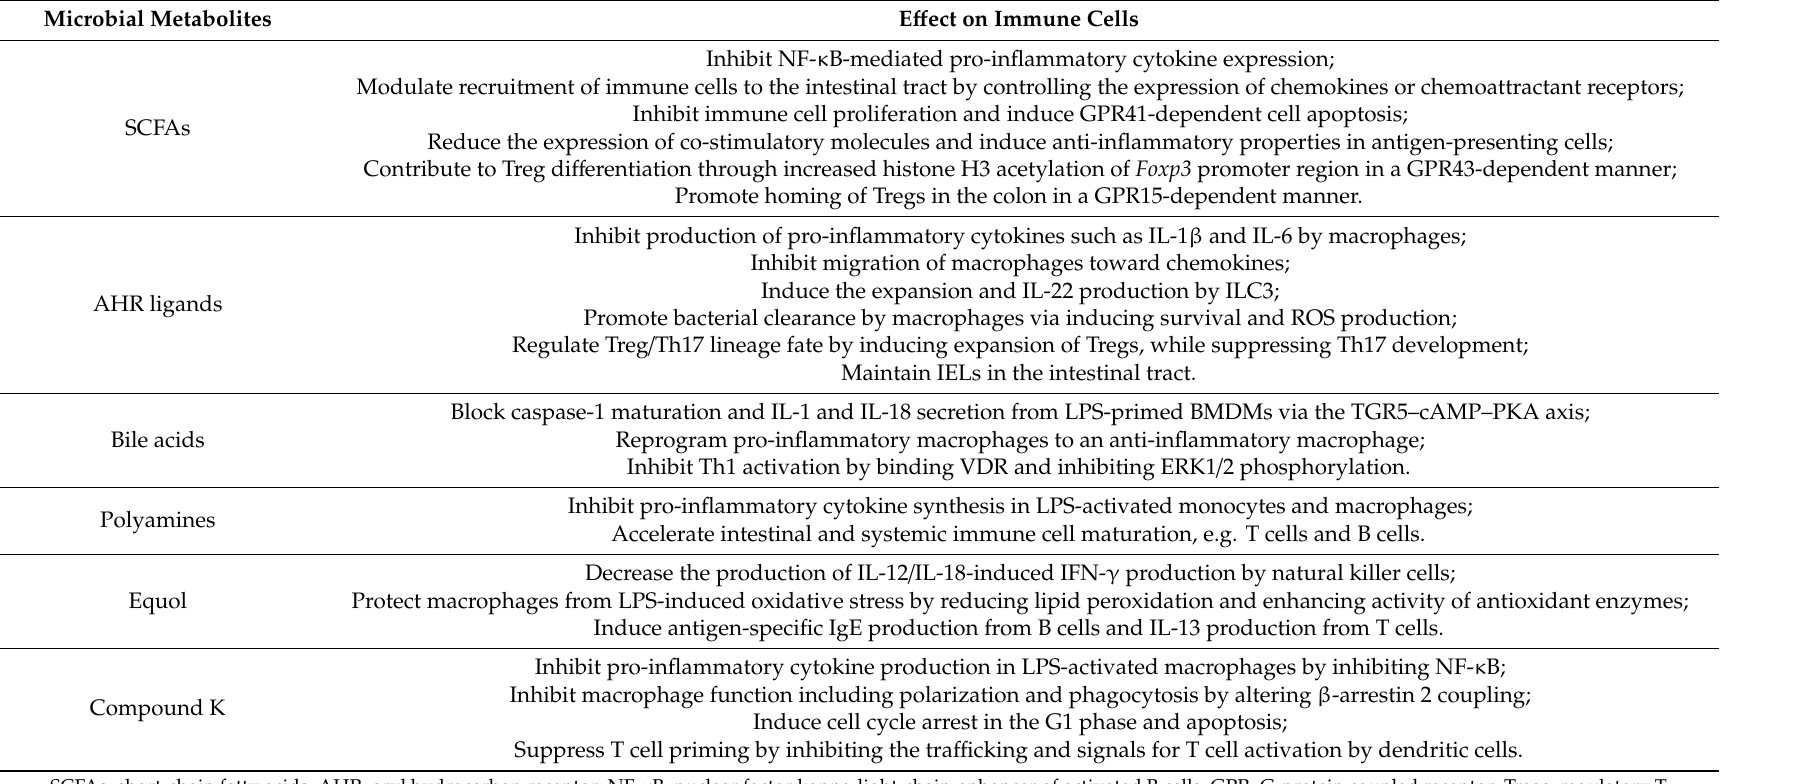
Table 2. E ff ect of microbial metabolites on immune